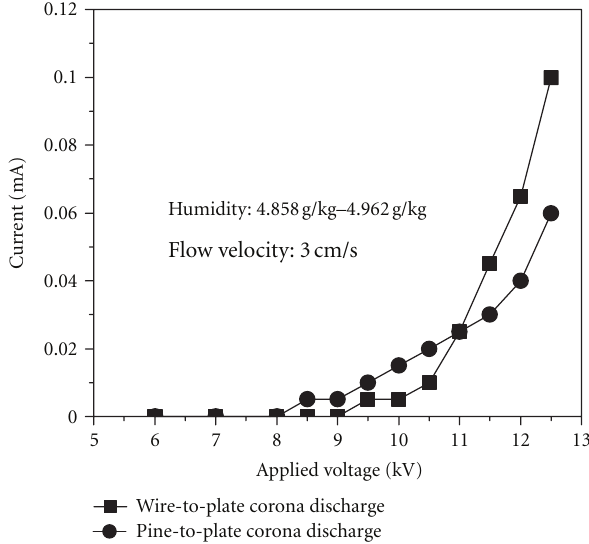
Figure 8: Corona current as a function of applied